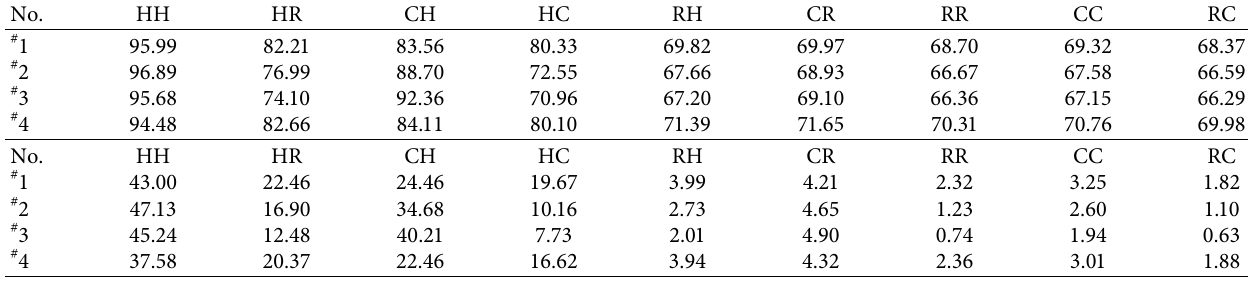
Table 10: Mean lengths of schedules returned by the LS algorithms for the benchmark given in [7, 8] with cov � 80%. No. HH HR